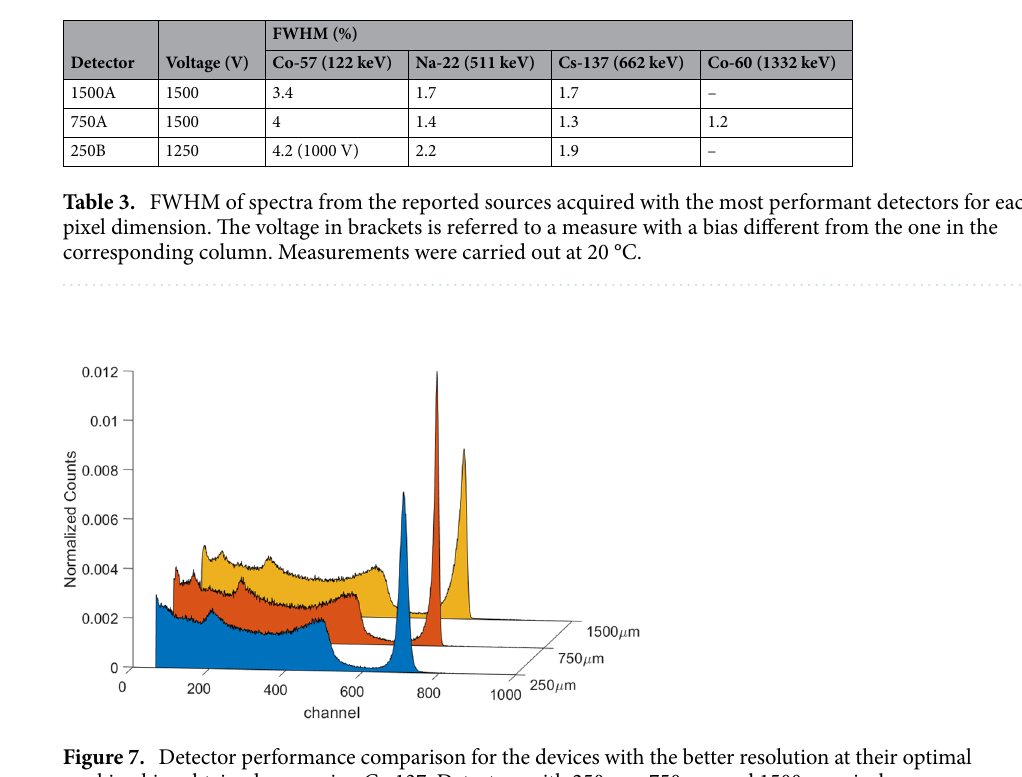
Figure 7. Detector performance comparison for the devices with the better resolution at their optimal working bias obtained measuring Cs-137. Detectors with 250 μm, 750 μm and 1500 μm pixels were compared. Measurements were carried out at 20